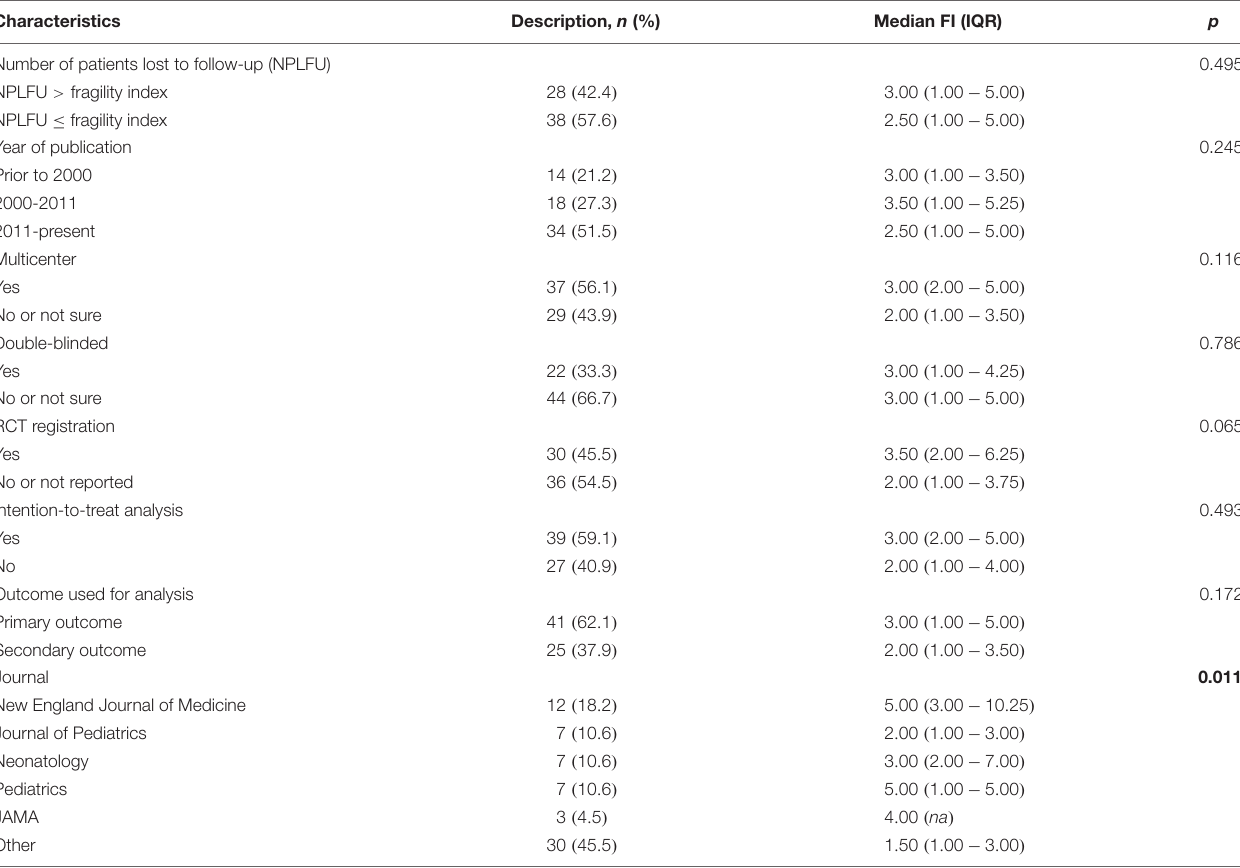
TABLE 1 | Characteristics of included trials and fragility index by subgroup.